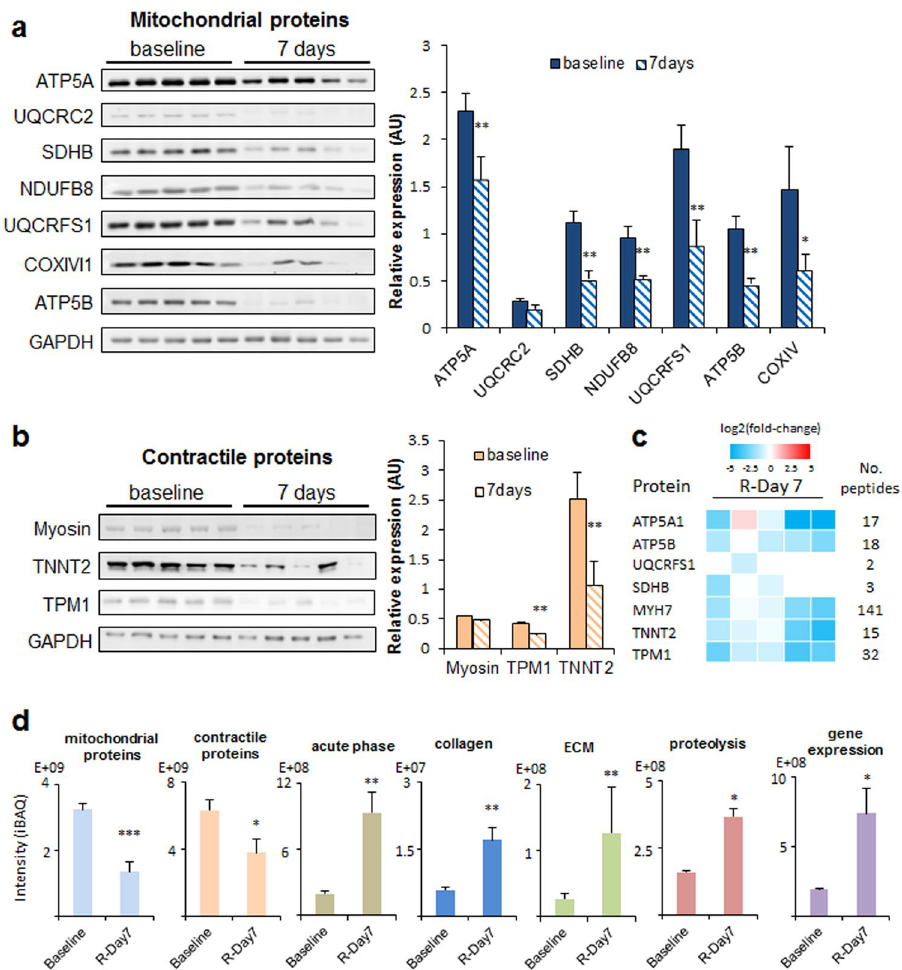
Figure 4. Validation of the most representatitve protein changes detected in ischemic myocardium after acute infarction. ( a ) Western blot analysis and corresponding quantitative densitometry of ATP5A, UQCRC2, SDHB, NDUFB8, UQCRFS1, COXIV and ATP5B confirming the decrease in mitochondrial protein content 7 days after reperfusion with respect to baseline. ( b ) Western blot analysis and quantitative densitometry of cardiac Myosin heavy chain, TNNT2 and TPM1 confirming the decrease in sarcomeric contractile proteins 7 days after reperfusion. Each lane of western blot corresponds to a protein extract obtained from one animal. Protein values are normalized relative to GAPDH. In the bar plots, results are shown as the mean ± s.e.m. of five determinations. * Indicates p value < 0.05; ** indicates p value < 0.01 versus baseline by Mann-Whitney test. Full-length blots from panels a and b are presented in Supplementary Figure S8 as well as their raw integrated densities before and after normalization can be consulted in Supplementary Figures S9 and S10. iTRAQ quantifications of the proteins from panels a and b are shown in the Supplementary Figure S11a for comparison. ( c ) Label free individual protein quantifications of ATP5A, ATP5B, UQCRFS1, SDHB, MYH7, TNNT2 and TPM1 confirming the decrease in mitochondrial and contractile protein content. Protein quantifications are represented as log2(fold-change) of iBAQ intensities of individual animals from R-Day 7 compared with pooled average of iBAQ intensities from all Baseline group animals. ( d ) Label free quantitative proteomics confirming the decrease in mitochondrial and contractile proteins and the increase in acute-phase related proteins, collagens, extracellular matrix proteins (ECM), proteolysis related proteins and gene expression related protein contents, 7 days after reperfusion with respect to the baseline. Protein abundances were expressed as the iBAQ values. Results are shown as the mean ± s.e.m of five determinations performed in individual animals, * indicates FDR < 0.05; ** indicates FDR < 0.01, *** indicates FDR < 0.001 versus baseline by Mann- Whitney test after Benjamini–Hochberg correction. Label free individual protein quantifications included in the mitochondrial, contractile, acute-phase, collagens, ECM, proteolysis and gene expression protein groups are shown in Supplementary Figure